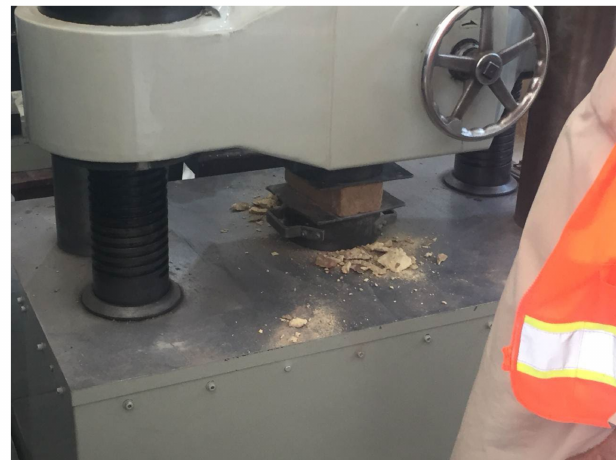
Figure 4. Compressive strength in universal testing